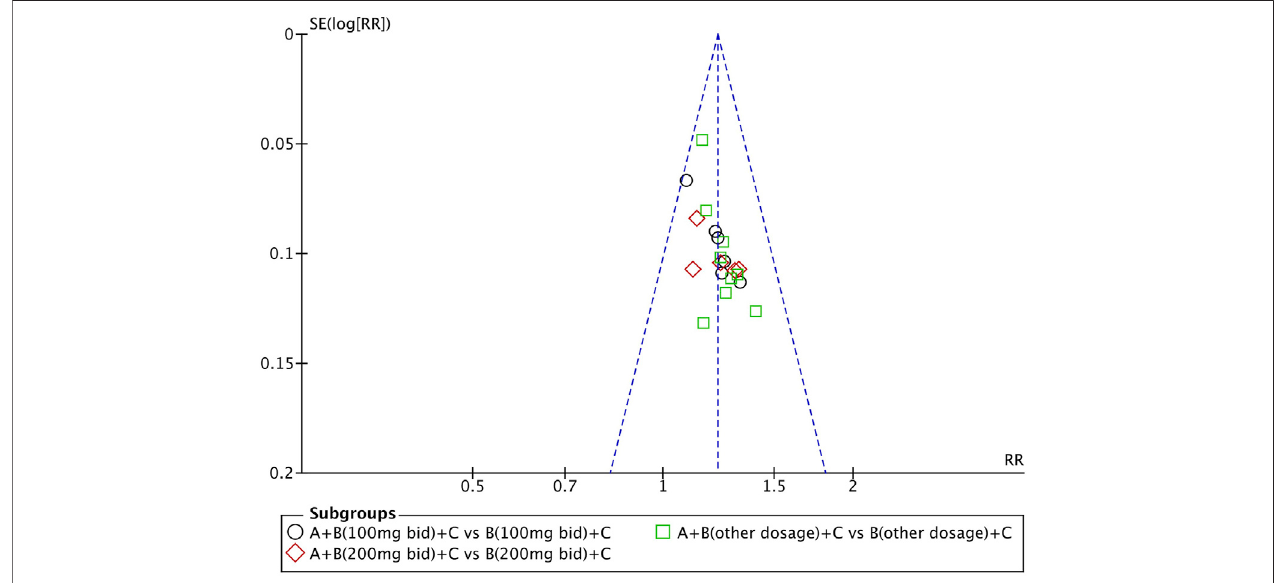
FIGURE 12 | Funnel plot of the clinical ef fi cacy rates: QQC combined with sacubitril/valsartan versus sacubitril/valsartan.